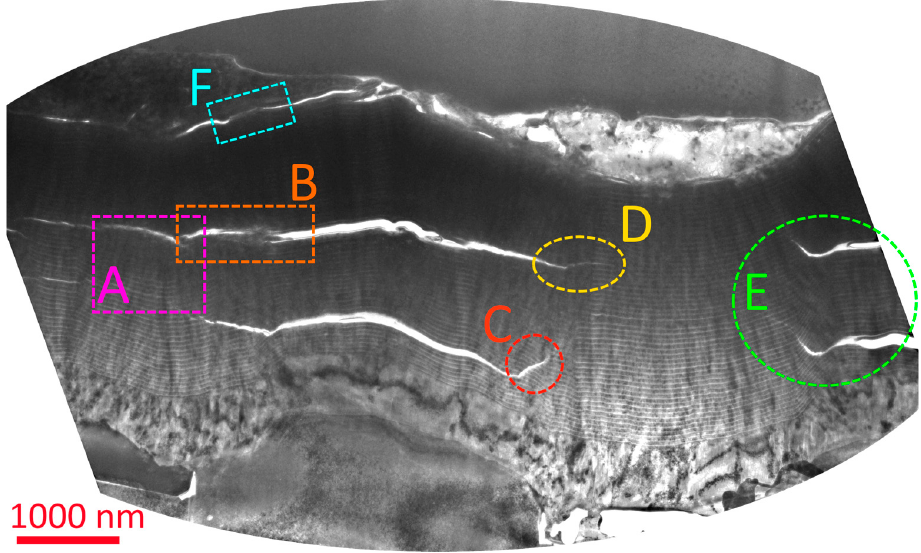
Figure 4. Investigation of the patterns of wear and fracture in Coating M1. General view of the lamella under study. Areas for further research are labeled A,B,C,D,E and F.